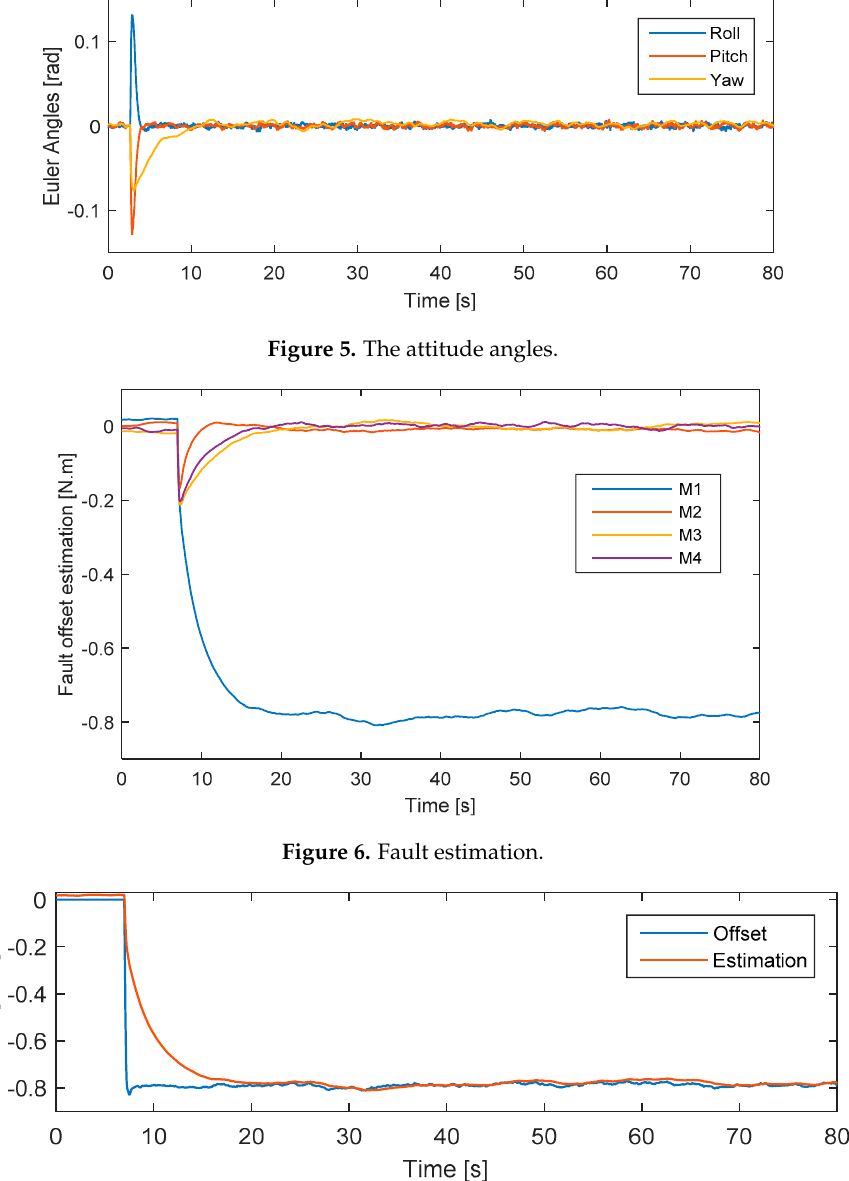
Figure 7. M1 offset by fault and its estimation.